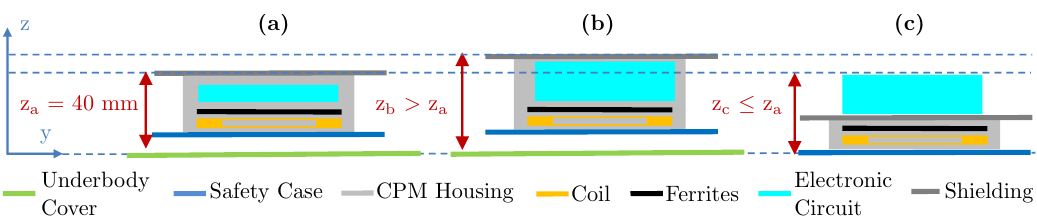
Figure 2. z-dimension of different WPTS constructions: ( a ) conventional construction for WPTS with a transmission power of 3.6kW given in [20], ( b ) conventional construction for WPTS with a transmission power of 11kW e.g. given in [23] and ( c ) proposed concept for WPTS with a transmission power of